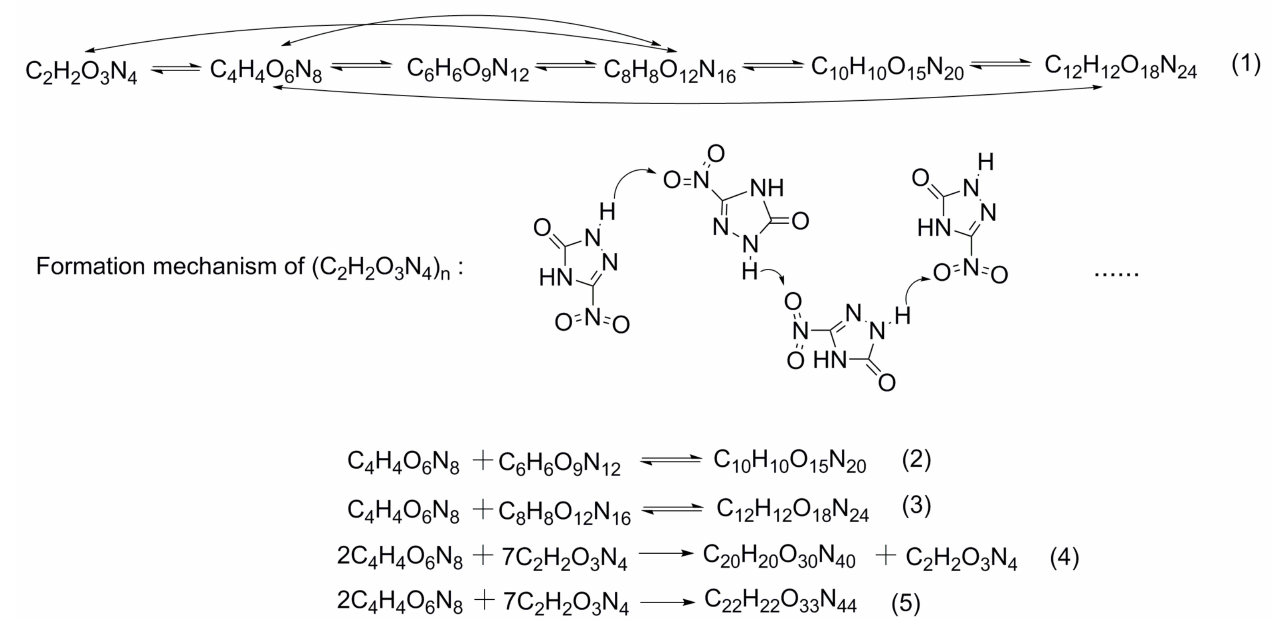
Figure 8. (C 2 H 2 O 3 N 4 ) n